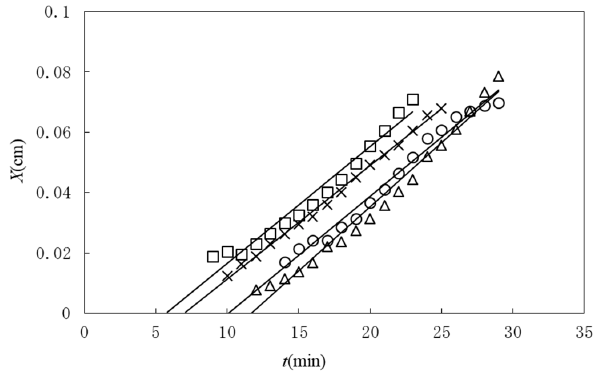
Figure 6. Time course of gel layer thickness observed on packed swine erythrocytes in contact with plasma with calcium chloride concentrations of 1.63 mM ( ○ ), 2.50 mM ( △ ), 4.59 mM ( □ ) and 6.68 mM ( × ).